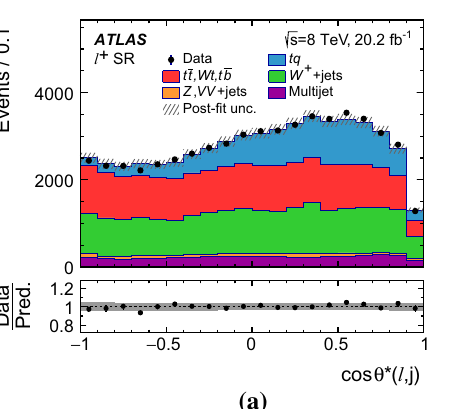
the total uncertainty in the rates of all processes after the fit and the bin-by-bin MC statistical uncertainty, added in quadrature The lower panels show the ratio of the observed to the expected number of events in each bin to illustrate the goodness-of-fit